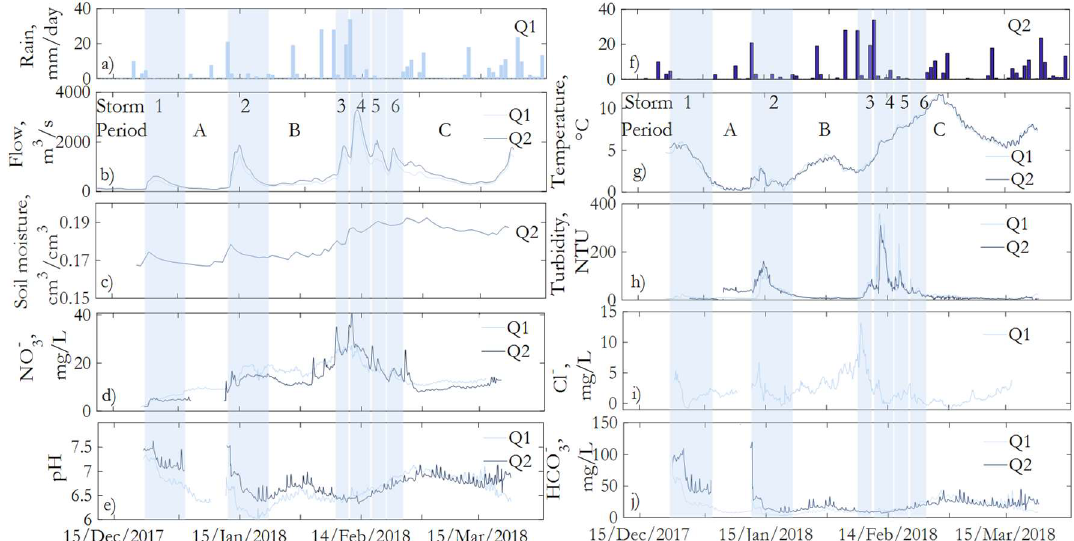
Figure 4. Time series area-averaged of precipitation ( a , f in location Q1 and Q2, respectively) were not immediately reflected in the increase in flow ( b ) due to the scale of the catchment; rather, the increase in flow was a consequence of the combined precipitation observed at drainage areas Q1 and Q2. Estimated soil moisture ( c ), water temperature ( g ), NO 3 ¯ ( d ), pH ( e ), turbidity ( h ) and Cl − ( i ), and HCO 3 ¯ ( j ) with Q1 and Q2 locations along the Kanawha River indicated in Figure 1. Table 2. Characteristics of six rainstorms at Q1 and Q2 locations along the Kanawha River. Mean concentrations of HCO 3 − (Table 3) of rainstorms were found to be higher with respect to the mean concentration observed in intercalated periods in either Q1 or Q2 Loca- locations. In addition, the mean concentrations of HCO 3 − in rainstorms 1–3 were equal or higher in Q2 than Q1. In contrast, the mean concentrations in rainstorms 4–6 were lower in Q2 than Q1. However, NO 3 − showed a continuous increase having the maximum in storm 4 and Cl − and followed a similar pattern having the maximum in storm 3; then, both ions